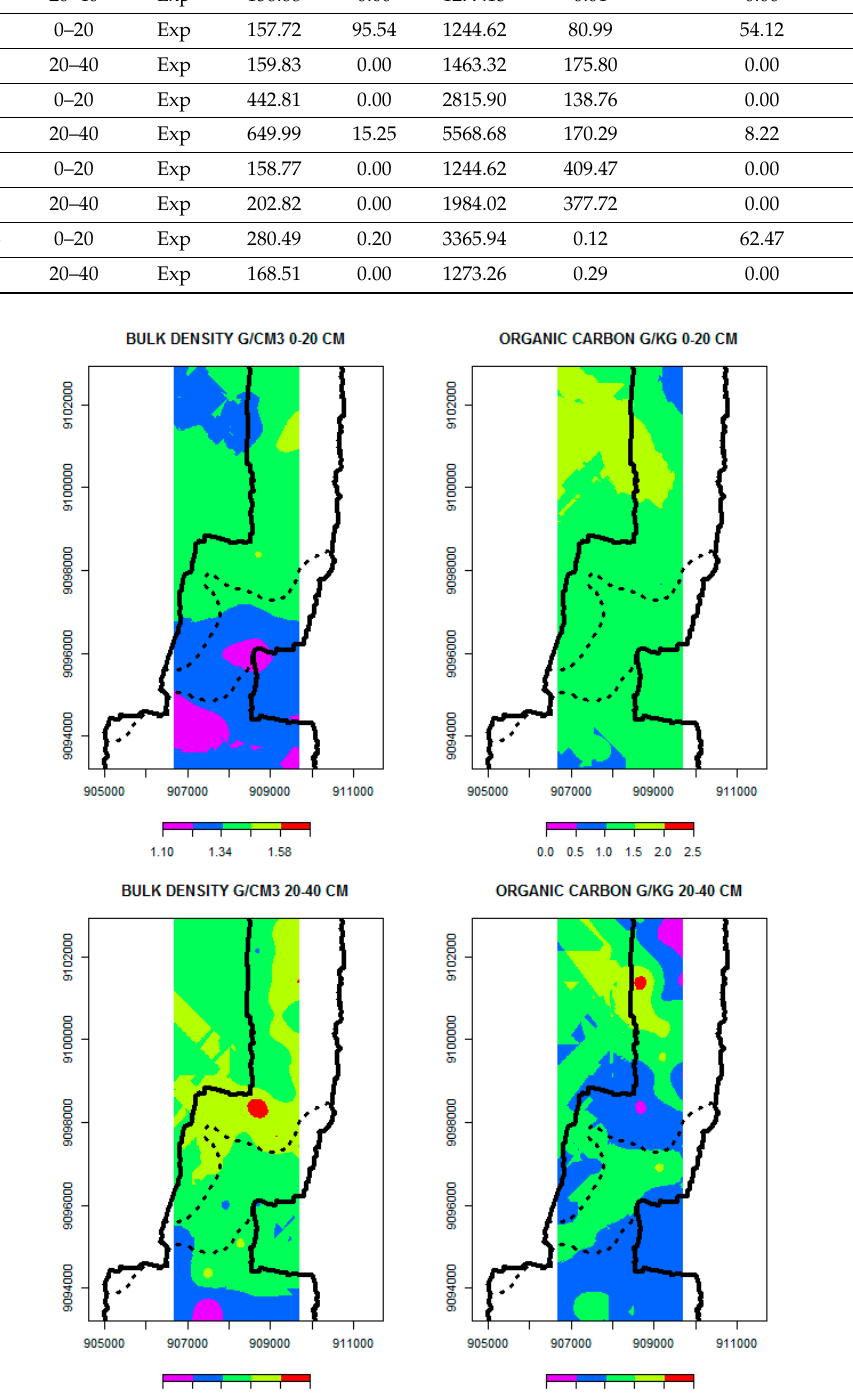
Figure 2. Spatial variation in bulk density, SOC along hydrological zones of transect derived from the geostatistical kriging method.